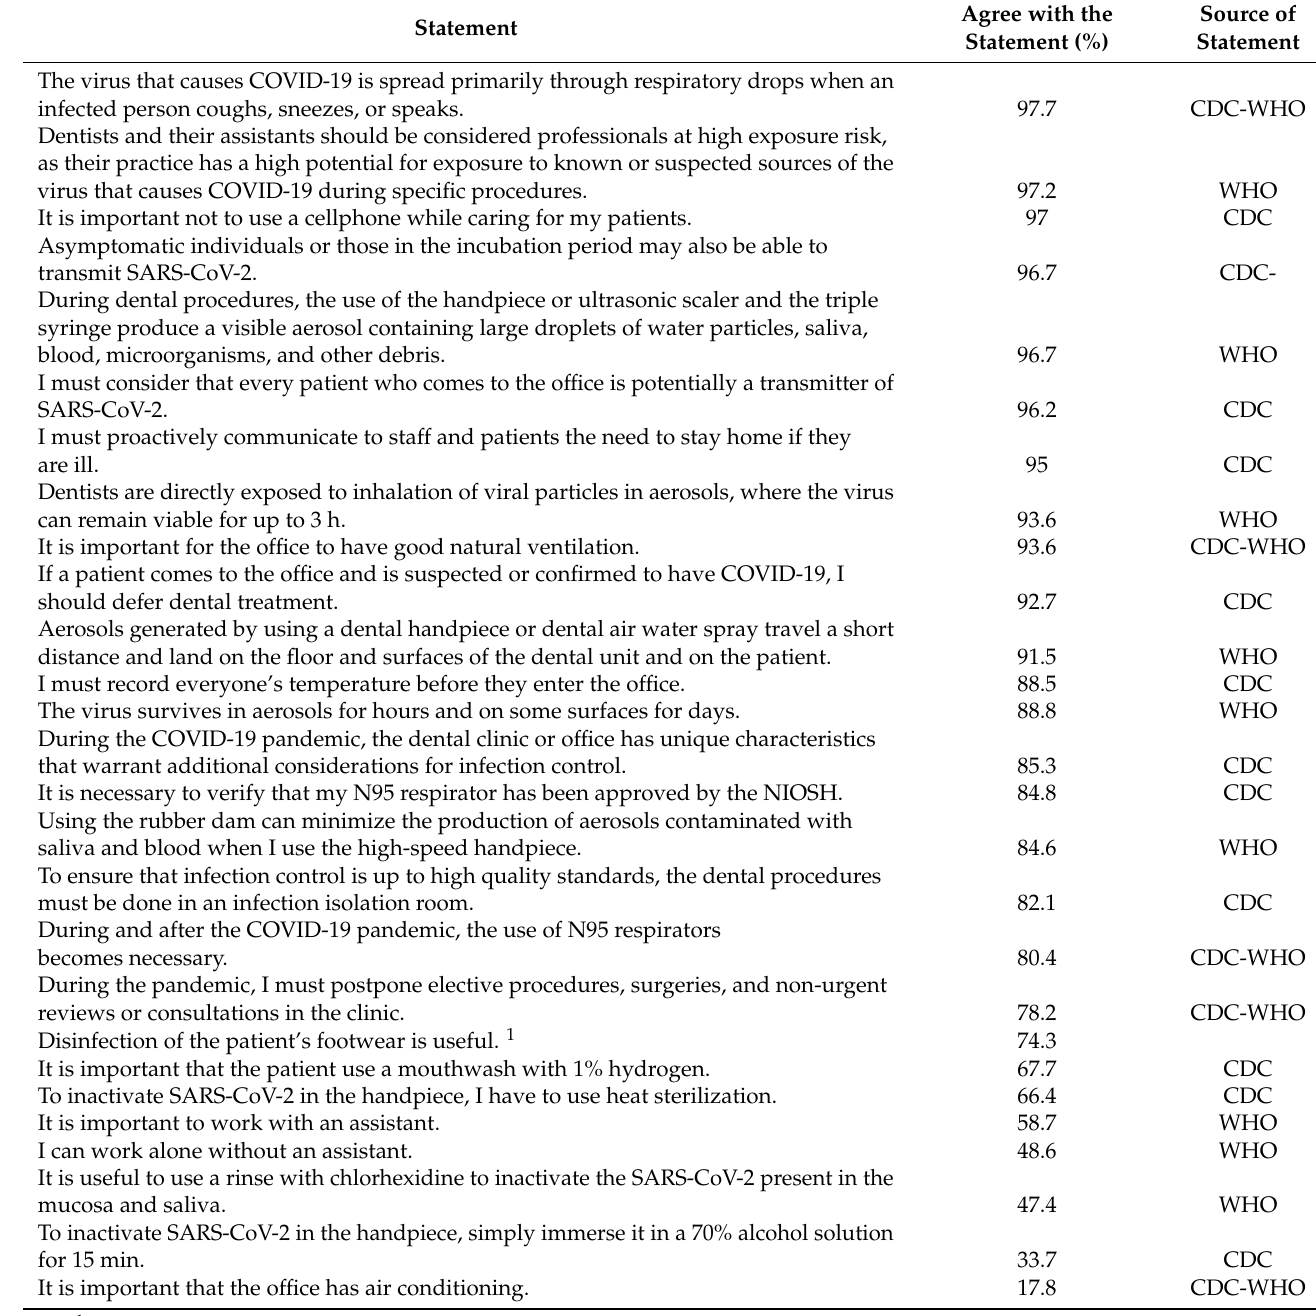
Table 6. General knowledge of the dentists regarding working safely during the COVID-19 pandemic ( n = 703).